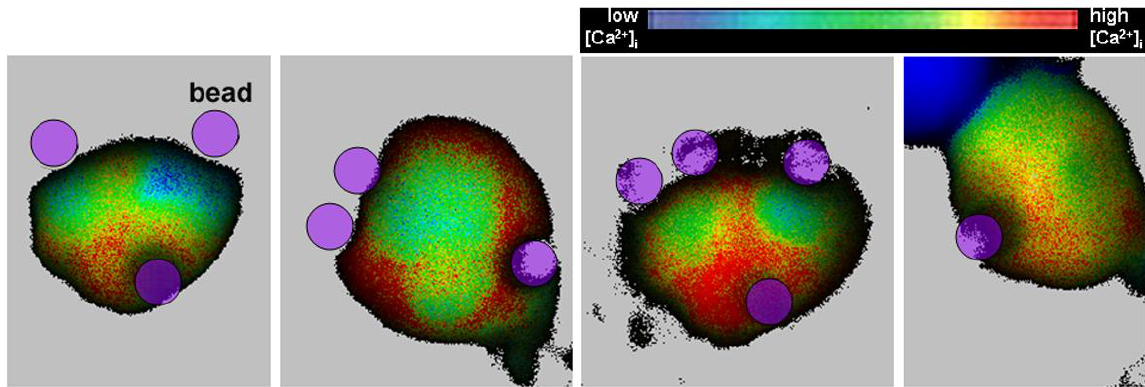
FIGURE 2 . Heterogeneities in cytosol Ca 2+ in B cells activated by anti-IgM–coated beads[13]. Examples of cytoplasmic Ca 2+ gradients in murine K46μ B cells responding to a polarized stimulus. In these experiments, anti-IgM–coated beads (outlined in purple) were brought into contact with K46μ cells labeled with intracellular Ca 2+ probe Fura-2AM and adhered to the bottom of microscopic dish. Static images (λ340/380 nm ratio; random time points <20 min) demonstrate distinct high- and low-Ca 2+ areas within the cytoplasm, reflecting different stages of signaling in the immune synapse area (beads were contacting B cells at random, thus interaction times were different). Each panel shows a single cell (40  magnification; cells are approximately 30 μm in